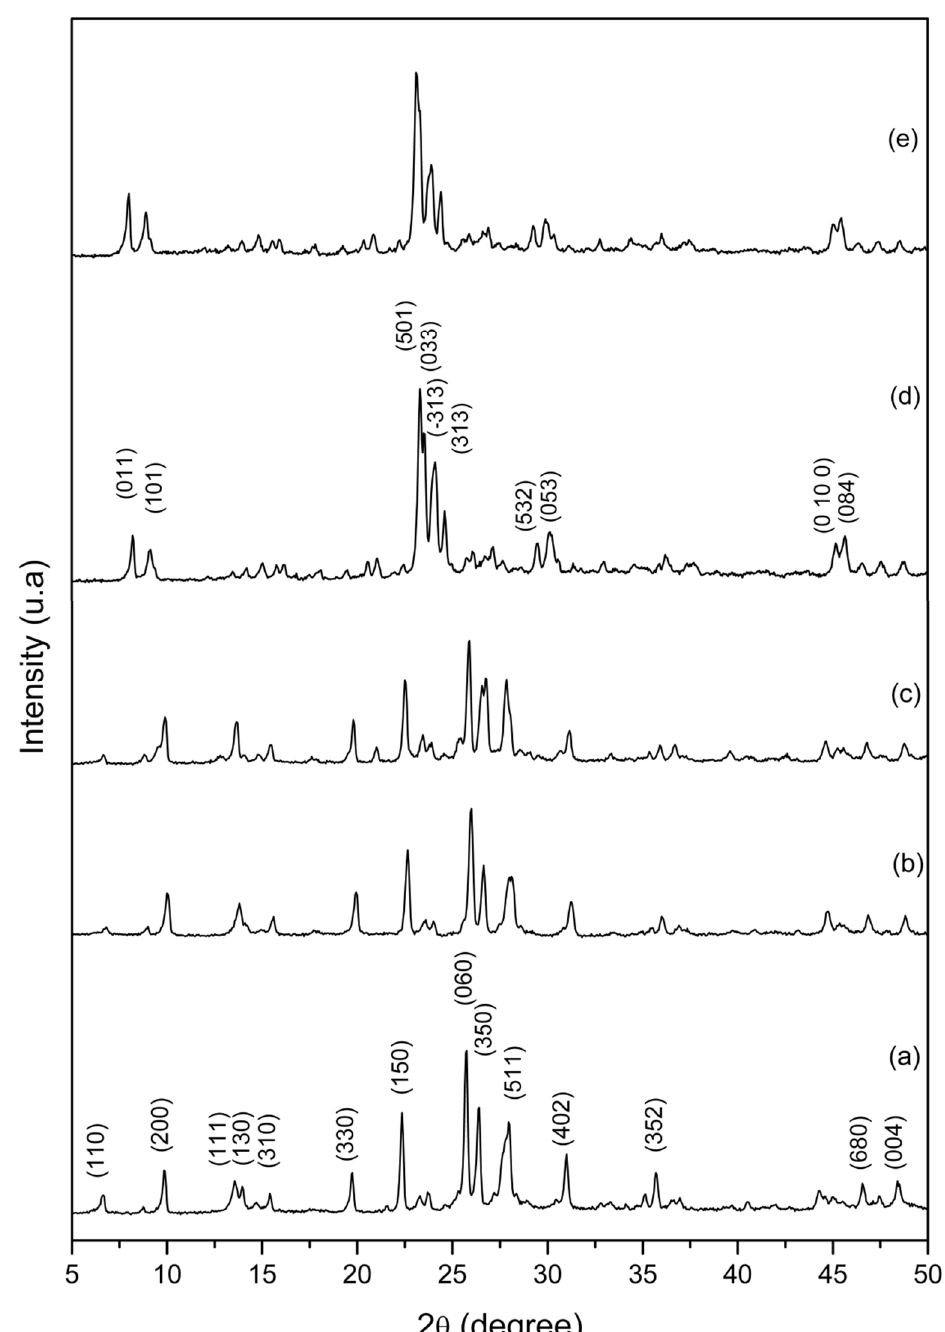
Figure 2. XRD patterns of ( a ) MOR/AS, ( b ) MOR/02, ( c ) MOR/SD, ( d ) ZSM-5/AS, ( e ) ZSM-5/02.